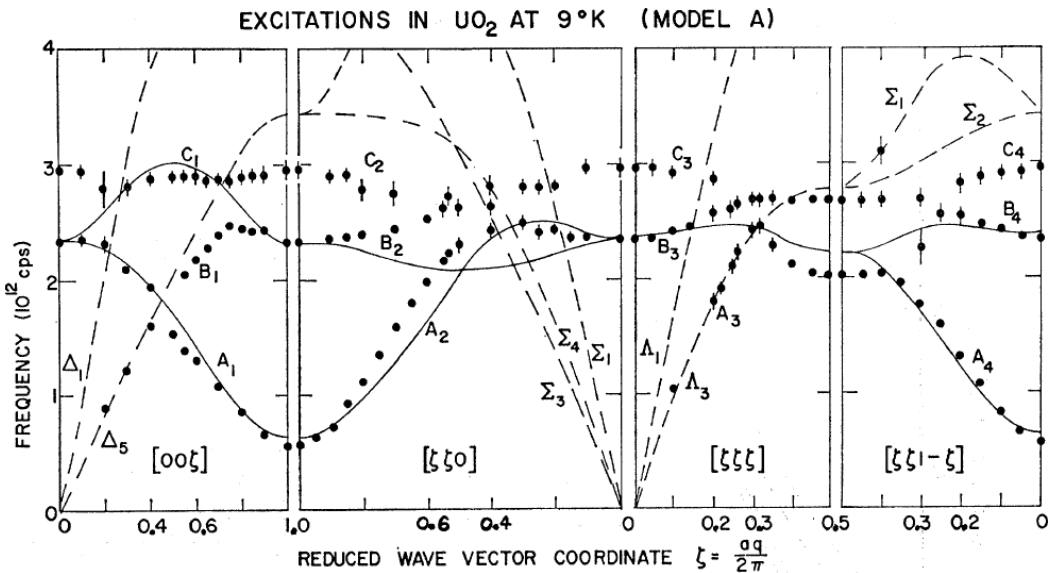
Figure 47. The measured dispersion relations for magnetic excitations in UO 2 at 9 K, propagating along four directions in the crystal. The dashed curves show the phonon dispersion relations appropriate to 296 K. The solid curves are the result of fitting to a model including exchange interactions between uranium moments and a single ion anisotropy term of the form ( S z ) 2 . This figure is taken from Figure 4 of ref. [120]. Copyright by the American Physical Society.